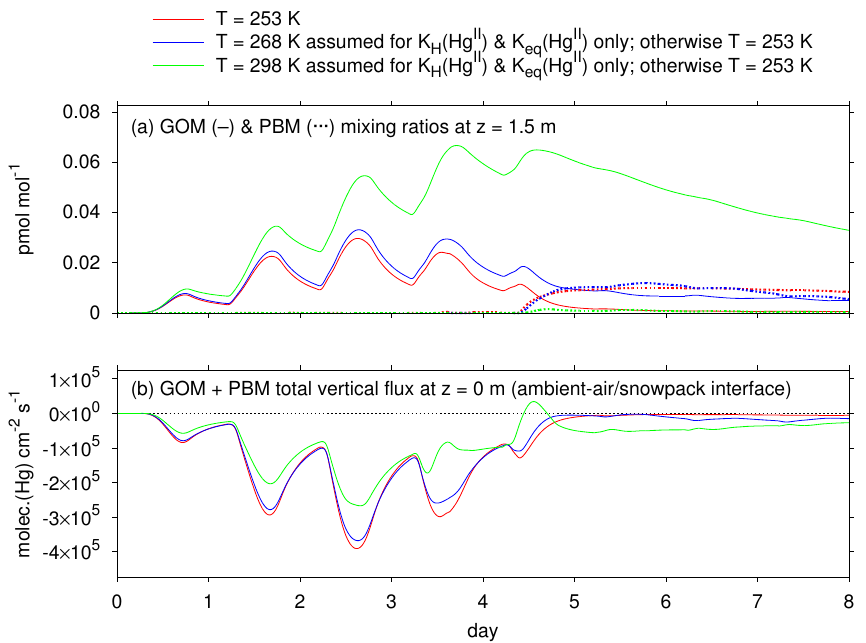
Fig. 6. Sensitivities of partitioning between GOM and PBM in the ambient air and their total air-snow fluxes on the choice of temperature-dependent thermodynamic parameters for Hg(II) species: (a) mixing ratios of GOM (solid lines) and PBM (dotted lines) simulated at z = 1 . 5 m in the ambient air above the snowpack and (b) total vertical fluxes of GOM and PBM at z = 0 m. Red lines denote a base case from a model run at U 2 = 4 . 5 ms − 1 and T = 253 K. Blue and green lines denote sensitivity runs performed with the same condition except that, for the calculations of Henry’s law ( K H ) and aqueous-phase stability constants for halide complexes ( K eq ) of Hg(II) species, T = 268 K and 298K, respectively, were assumed. Scenario 1A was employed for mercury chemistry in all model runs.